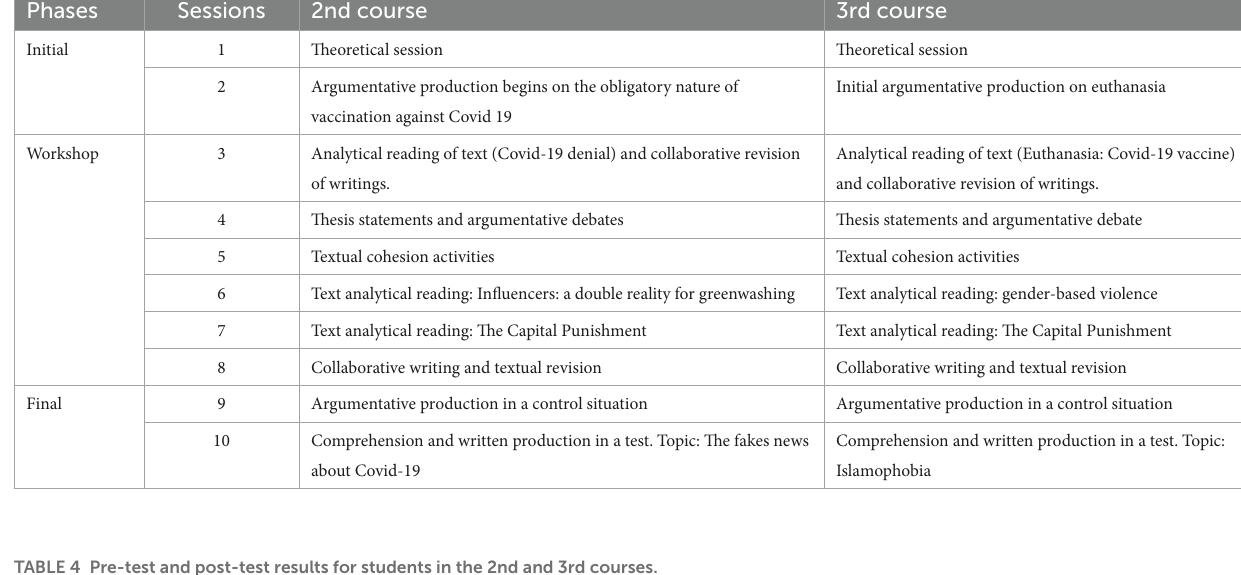
TABLE 4 Pre-test and post-test results for students in the 2nd and 3rd courses.